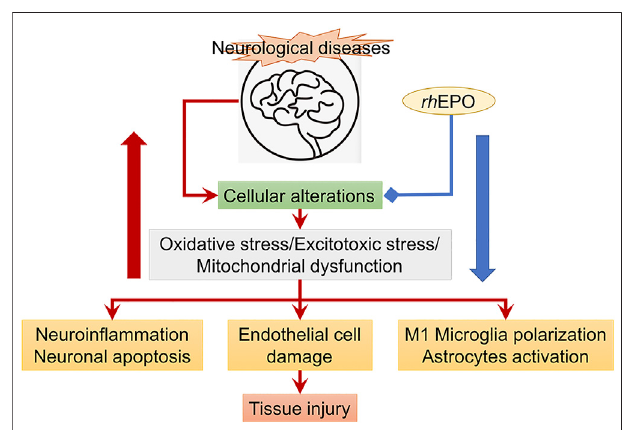
FIGURE 4 | rh EPO treatment (blue line) attenuates cellular alterations (read arrows) resulted from ischemic stroke. The red big arrow refers to increased cellular alterations, while the blue big arrow refers to inhibition of cellular alterations and the subsequent tissue